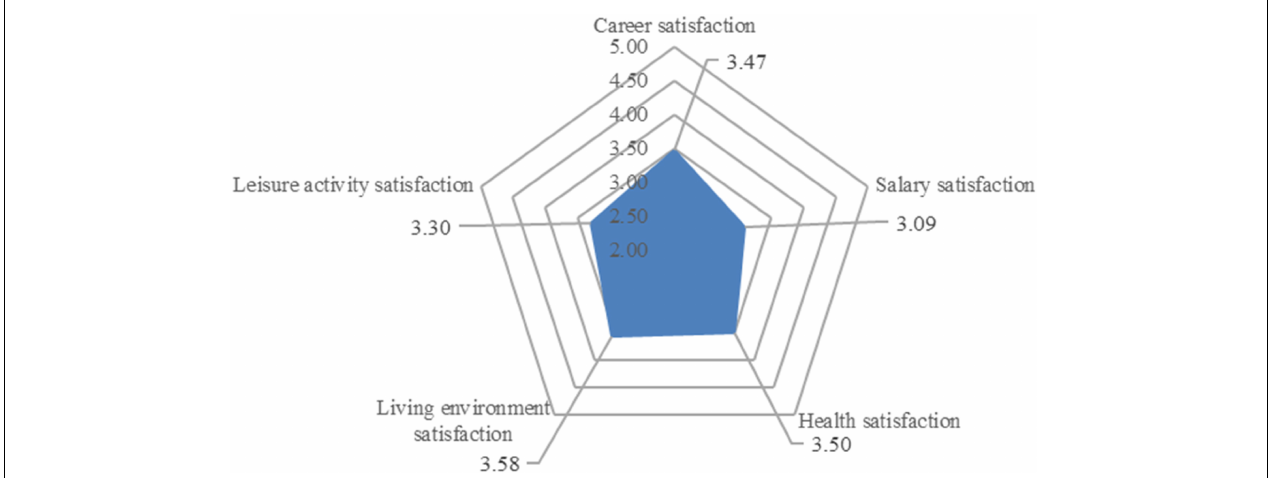
FIGURE 3 | The life satisfaction score of professional